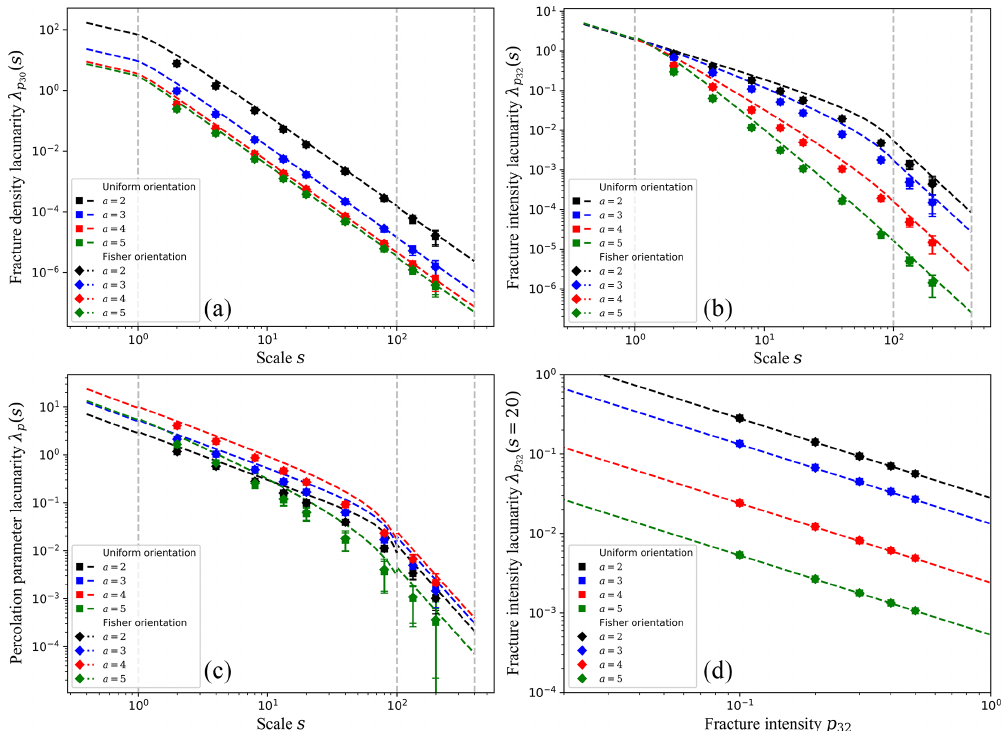
(s) , (b) λ p (s) , (c) λ p (s) for networks following power-law fracture size distributions 30 32 at fixed scale ( s = 20) with fracture bulk intensity 32